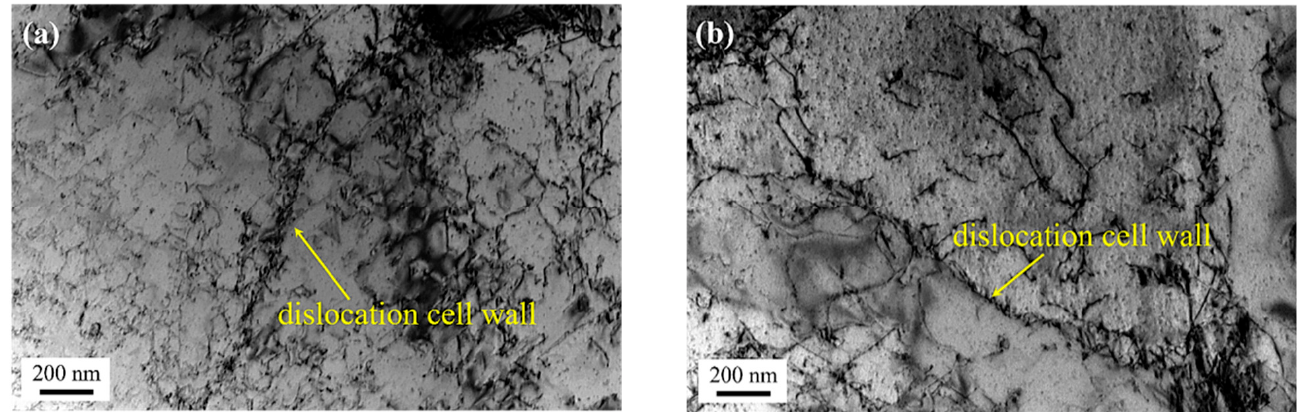
10 of 21 Figure 4. TEM micrographs of regions adjacent to the top surface layer of the SMAT processed con- dition of the SS 316L specimen and magnified view of a selected locations: ( a ) bright-field image of a nano-grained layer; ( b ) higher magnification micrograph of nanograins in the region marked by the red rectangle in ( a ); ( c ) SAED of nanograins; ( d ) bright-field image showing nanotwins and slip bands, ( e ) dark-field image highlighting the nanotwins; ( f ) SAED of the nanotwins. With a further increase in the specimen depth analyzed, i.e., at a larger distance to the treated surface, Figure 5a,b shows TEM bright-field images of the local microstructure (in a distance from the surface of approximately 1.0–1.2 mm corresponding to layer 3 in Figure 6). From both micrographs, it can be deduced that within the investigated region, dislocation cell walls (marked by the yellow arrows) were formed during the SMAT pro- cessing. As will be pointed out by the results of hardness investigations in Section 3.3 (cf. Figure 7), the area under investigation in Figure 5 corresponded to the non-affected as-